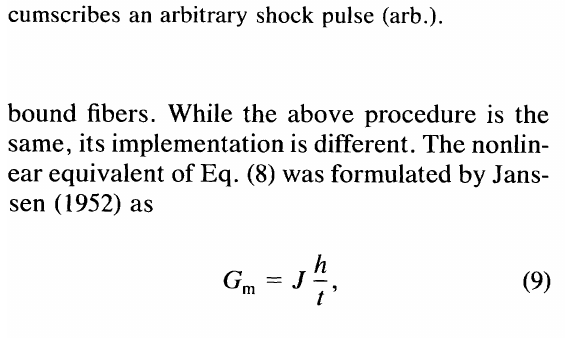
FIGURE 5 A rectangular shock pulse (rect.) that cir cumscribes an arbitrary shock pulse (arb.).